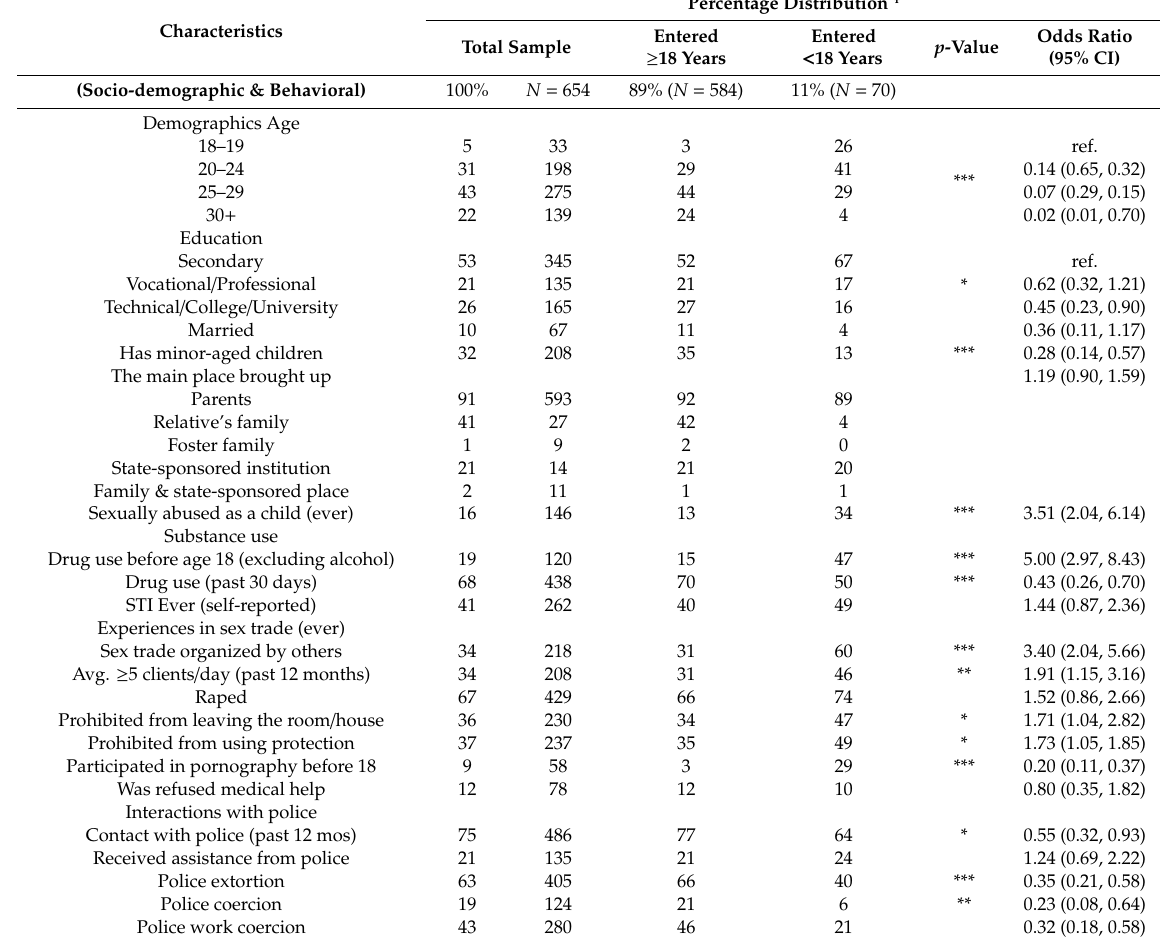
Table 1. Socio-demographic and behavioral characteristics of women in the sex trade in St. Petersburg and Orenburg, Russia ( N = 654).